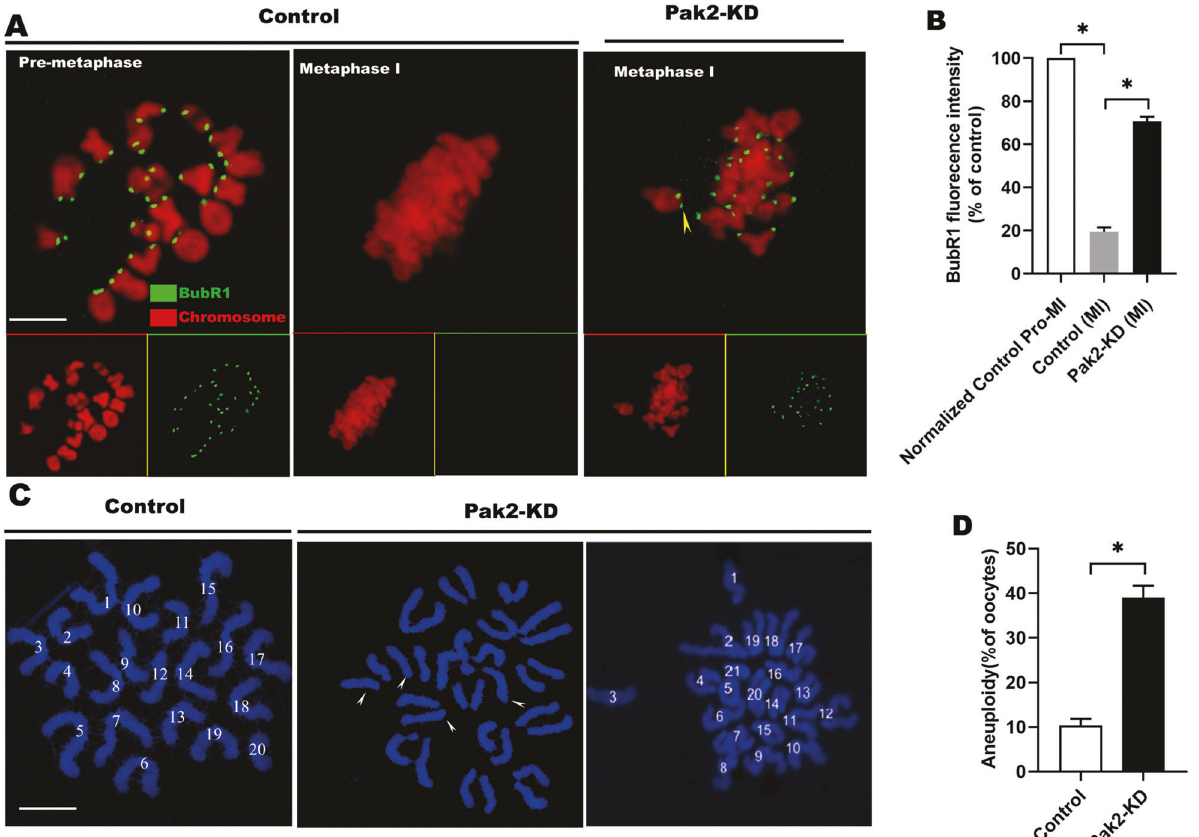
Fig. 4 Reduced PAK2 activates the SAC and increases the incidence of aneuploidy. A Control and Pak2 -KD oocytes were immunolabeled with anti-BubR1 antibody (green) and counterstained with PI to examine chromosomes (red). Representative confocal images of pre-MI and MI oocytes are shown. Arrowheads indicate scattered chromosomes in Pak2 -KD oocytes (scale bar, 2.5 μ m). B Quanti fi cation of BubR1 fl uorescence intensity in control and Pak2 -KD oocytes (19.3 ± 1.70%, n = 46, control; 70.7 ± 1.70%, n = 42, Pak2 -KD). C Chromosome spreads of control and Pak2 -KD MII oocytes (chromosomes were stained with Hoechst 33342 [blue]). Representative confocal images show euploid control oocytes and aneuploid Pak2 -KD oocytes. Arrows indicate the premature separation of sister chromatids (scale bar, 2.5 μ m). D Quanti fi cation of aneuploidy in control ( n = 43) and Pak2 -KD ( n = 50) oocytes (10.3 ± 1.25%, n = 43, control; 39.0 ± 2.16%, n = 50, Pak2 -KD). Graph shows the mean ± SD of the results obtained from three independent experiments. *Signi fi cantly different ( p <